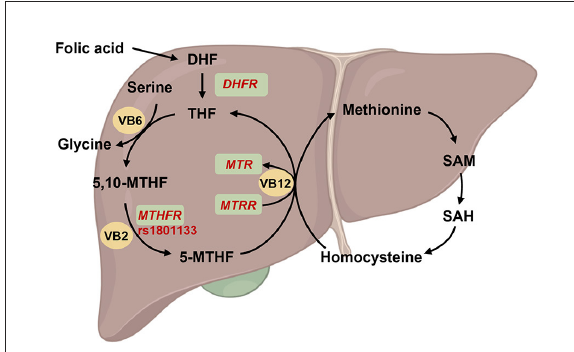
FIGURE4 Overview of the function of MTHFR on folate metabolism. The folic acid is reverted to dihydrofolate (DHF) and subsequently to tetrahydrofolate (THF) by dihydrofolate reductase (encoded by DHFR ), and then THF was conversed to methylenetetrahydrofolate (5,10-MTHF). On the other hand, THF involved in the cycle of glycine synthesis from serine with vitamin B6 (VB6) catalysis. Subsequently, 5,10-MTHF was reverted to methylated tetrahydrofolate (5-MTHF) by methylenetetrahydrofolate reductase (encoded by MTHFR ) and vitamin B2 (VB2) catalysis. 5-MTHF will be transform into THF and participated into homocysteine-methionine cycle by 5-methyltetrahydrofolate-homocysteine methyltransferase (encoded by MTR ) and methionine synthase reductase (encoded by MTRR ) under vitamin B12 (VB12) catalysis. Created with